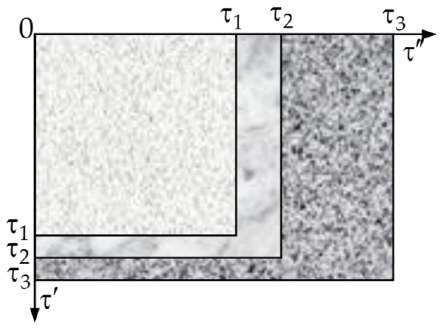
Figure 13. Schematic representation of set of integration regions in the points τ = τ 1 , τ = τ 2 , τ = τ 3 for g ( τ ) = ατ , α >